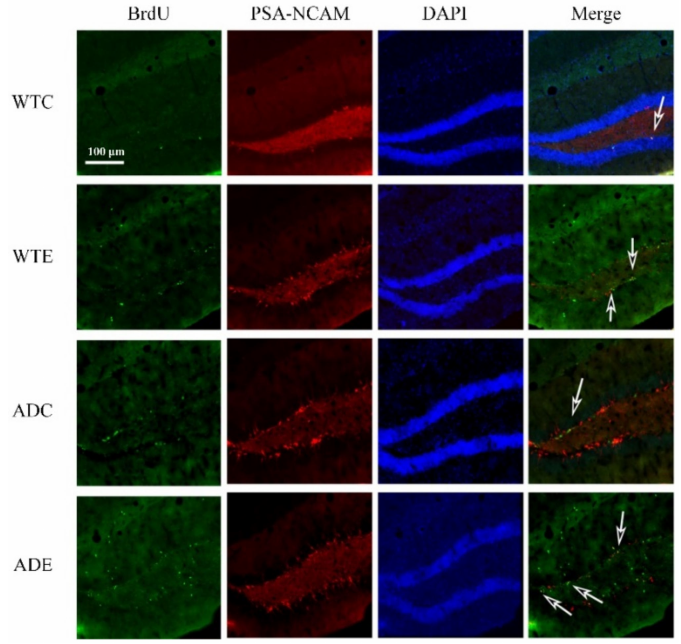
Figure A2. Effect of treadmill exercise on NSC proliferation in mice. Fluorescence staining images of BrdU/PSA-NCAM-positive cells. The arrows point to the BrdU/PSA-NCAM co-localization- positive